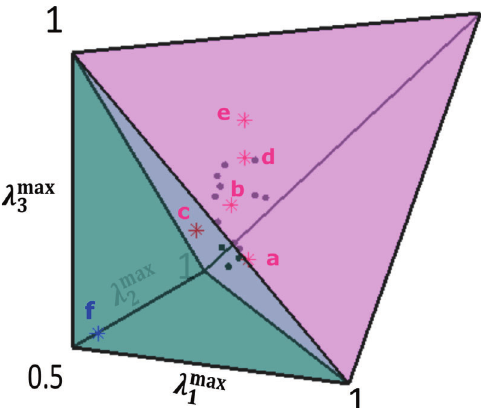
Fig. 3 Three-dimensional polytopes. The pink region represents the W class, and the union of the pink region and the green region is the GHZ class. The red stars and the dark dots are for the state | Ψ (1) 〉 , while the blue star ‘ f ’ is for the state | Ψ (2) 〉 . Detailed values for the data points a , b , c , d , e, and f can be found in Table 1b; for the rest see Supplementary Material, Table 3